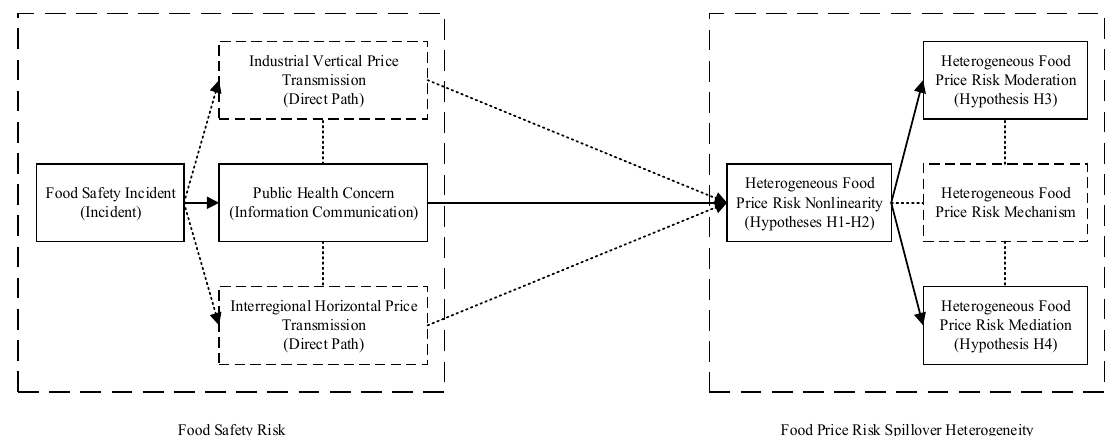
Figure 3. Analytical framework of heterogeneity. Source: Originally developed by the authors.